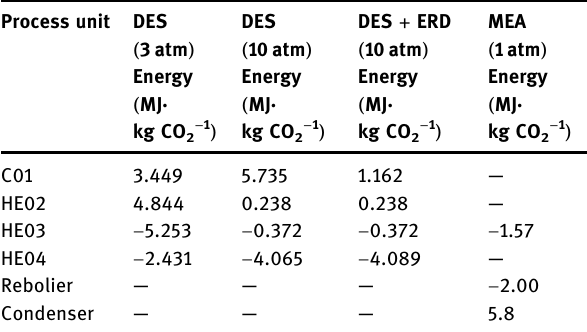
Table 6: Units ’ speci fi c energy requirement for CO 2 capture process Process unit DES ( 3 atm